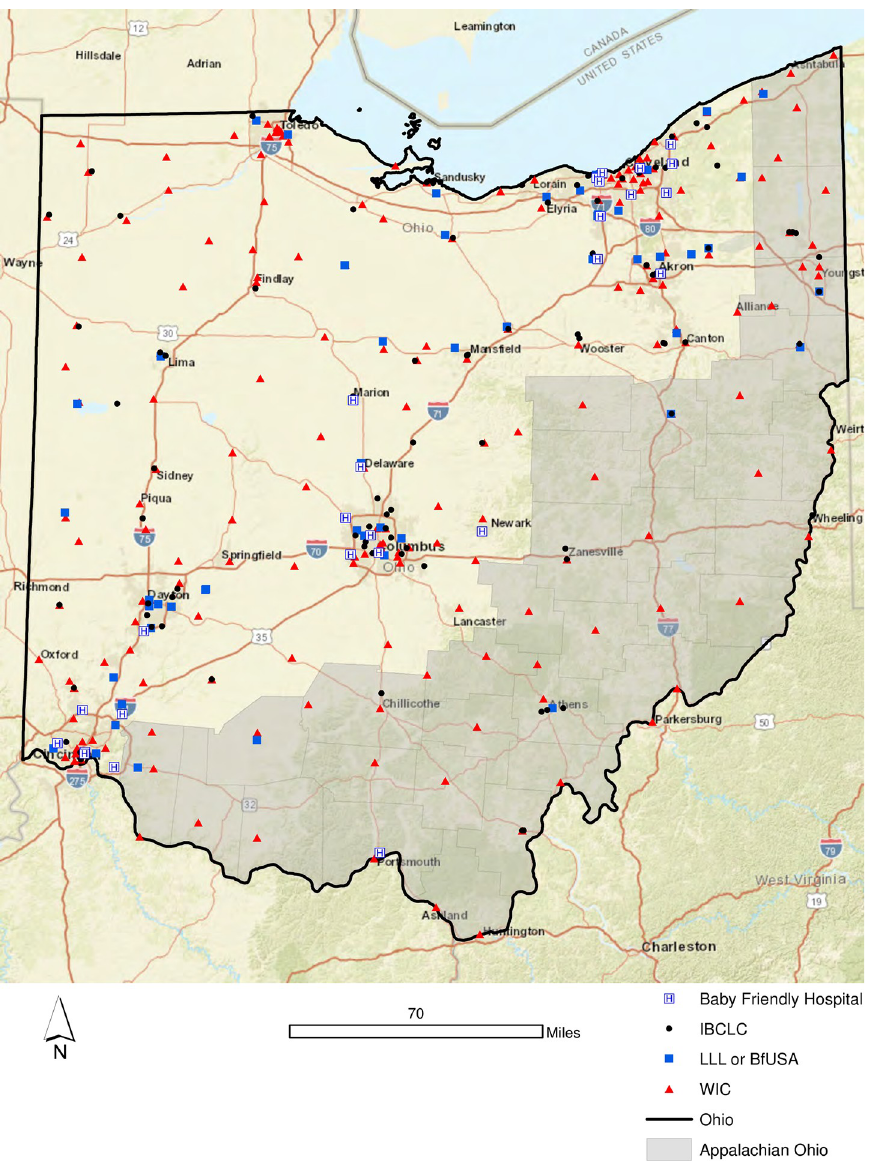
Fig 2. Breastfeeding support options available in the state of Ohio,